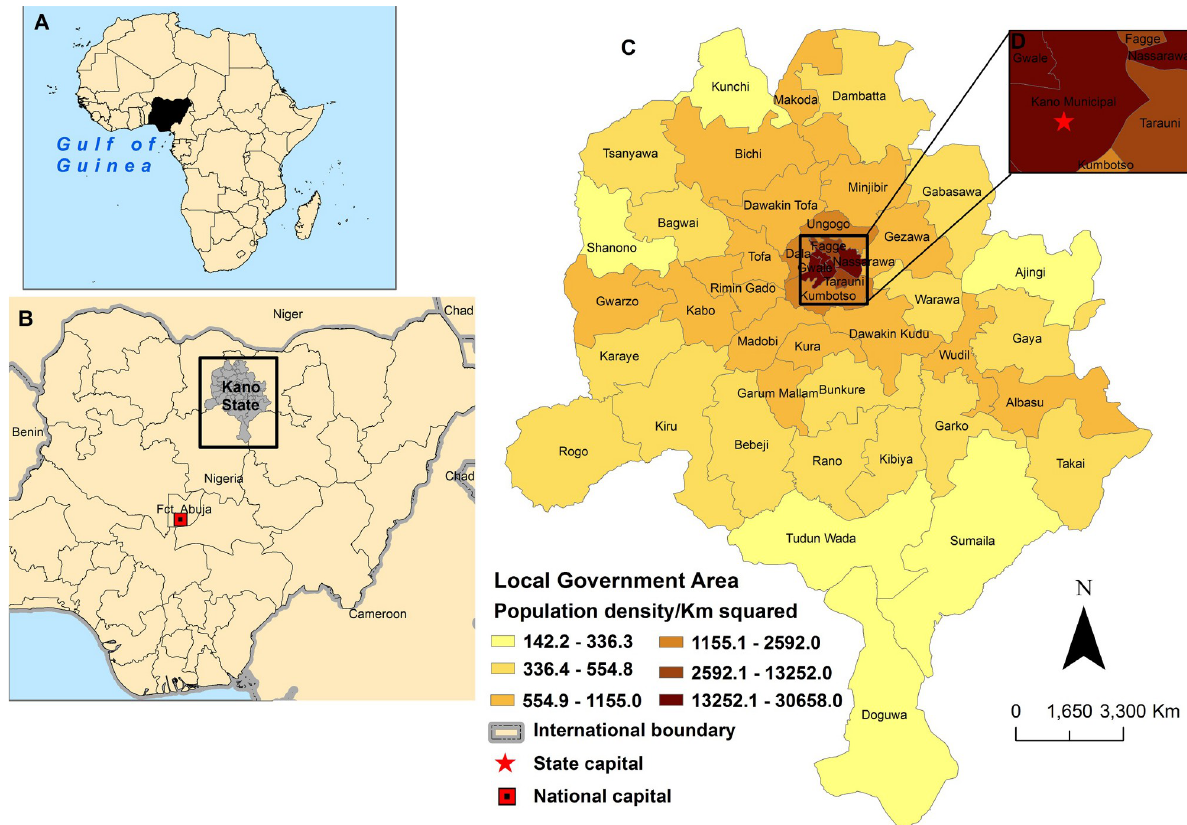
Fig 1. Map of our study setting describes the population density distribution of Kano State. Insert (A) shows Nigeria within Africa while (B) depicts Nigeria capital Abuja and Kano State within Nigeria. Insert (C) depicts population density of the 44 Local Government Areas of Kano State and insert (D) shows a better view of Kano Municipal, the capital of Kano